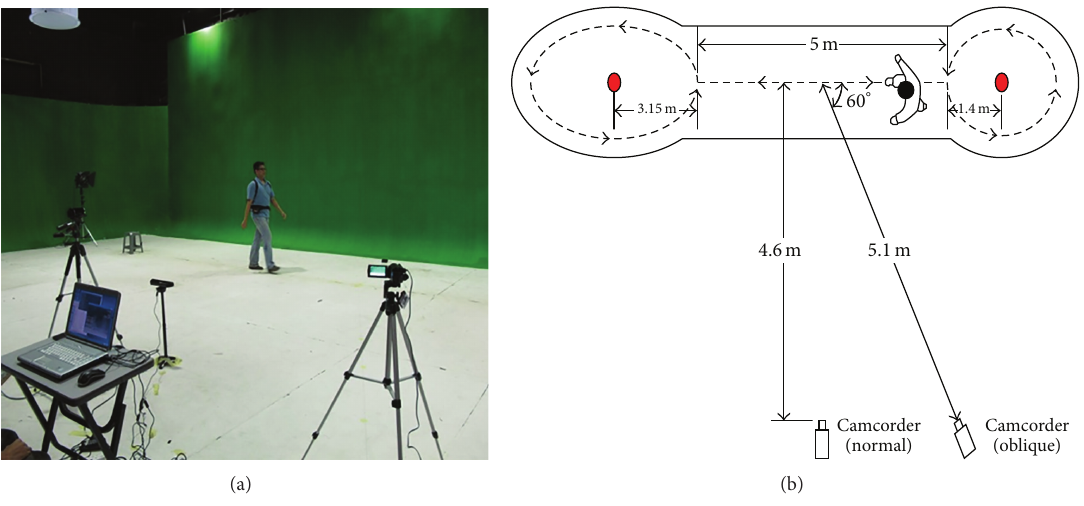
Figure 2: (a) The acquisition environment. (b) The recording